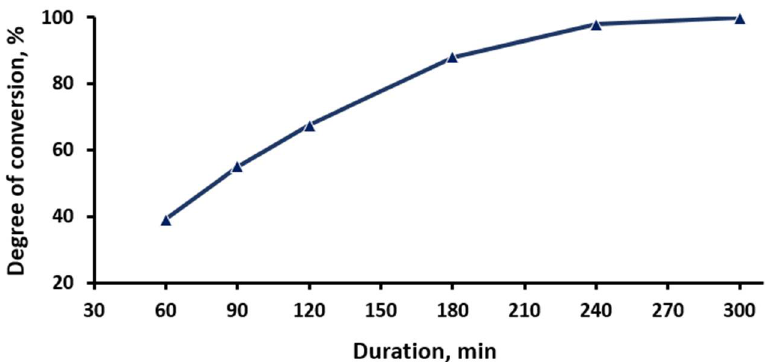
Figure 5. Dependence of the conversion degree of titanium fluorides into titanium dioxide on the process duration.